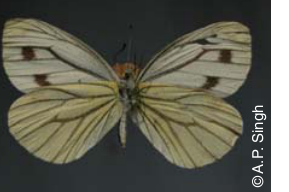
Image 128. Mountain Green-veined White, Pieris montana (upper)